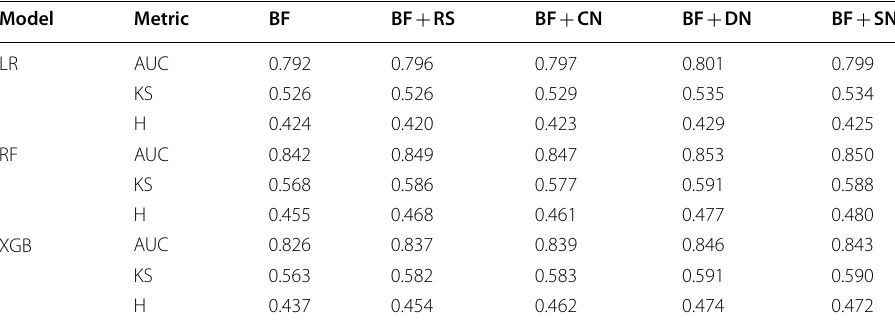
Each metric is measured by the mean of 100 estimates obtained by repeating the outer ten-fold cross-validation procedure ten times